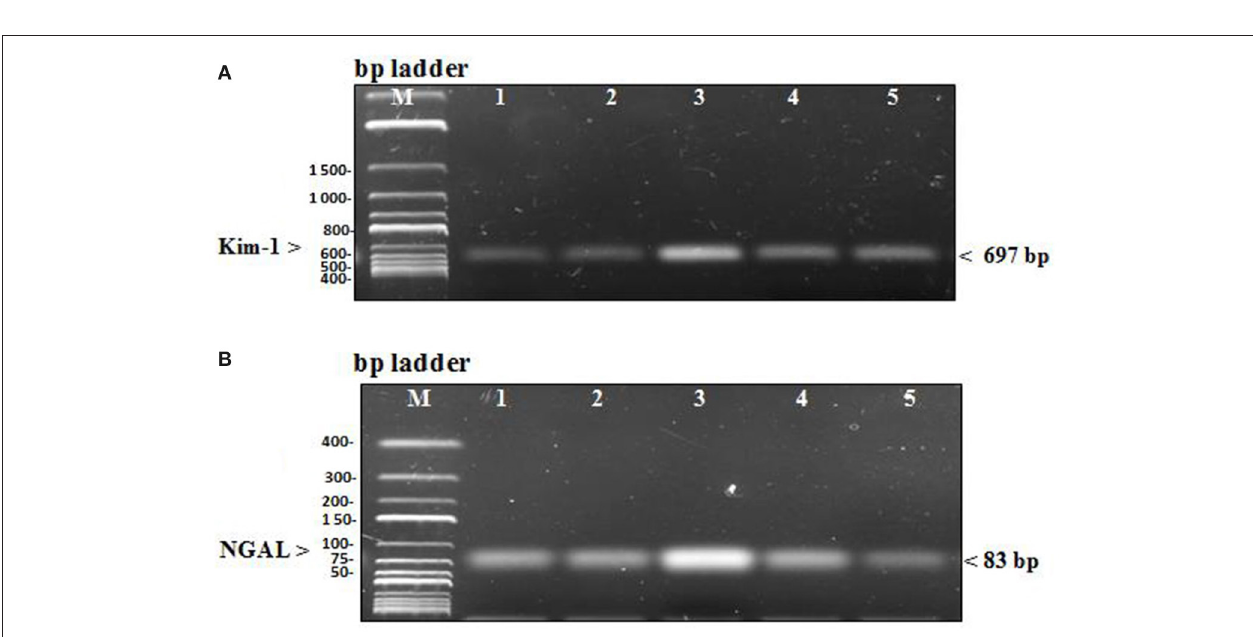
FIGURE 5 | (A) Relative gene expression of Kim-1 for mean of experimental groups with their standard deviation. (B) Relative gene expression of NGAL for the mean of experimental groups with their standard deviation. Each data are presented as mean fold change ± SD using ANOVA, p < 0.05.